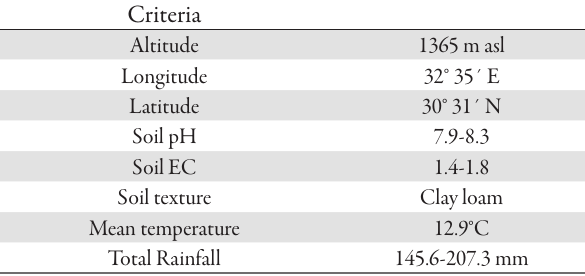
Tab. 1. Characteristics of the cultivation site and climatic conditions in Shoubak region south of Jordan during the